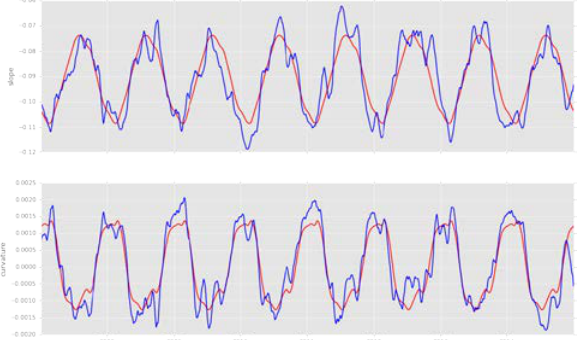
Figure 7: Yearly slope / curvature (red) versus daily slope / curvature (blue)